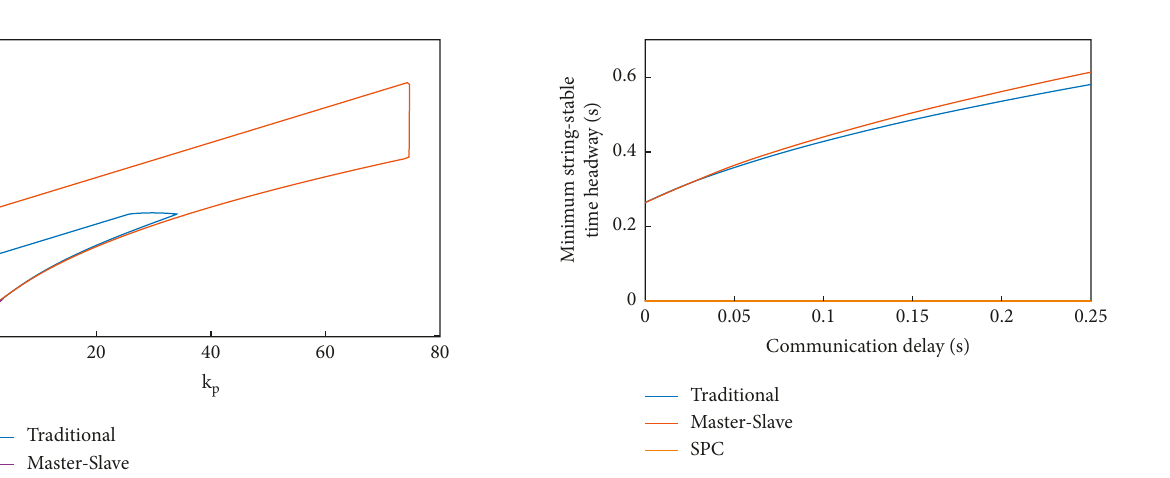
Figure 7: The minimum string-stable time headway of different architectures. Figure